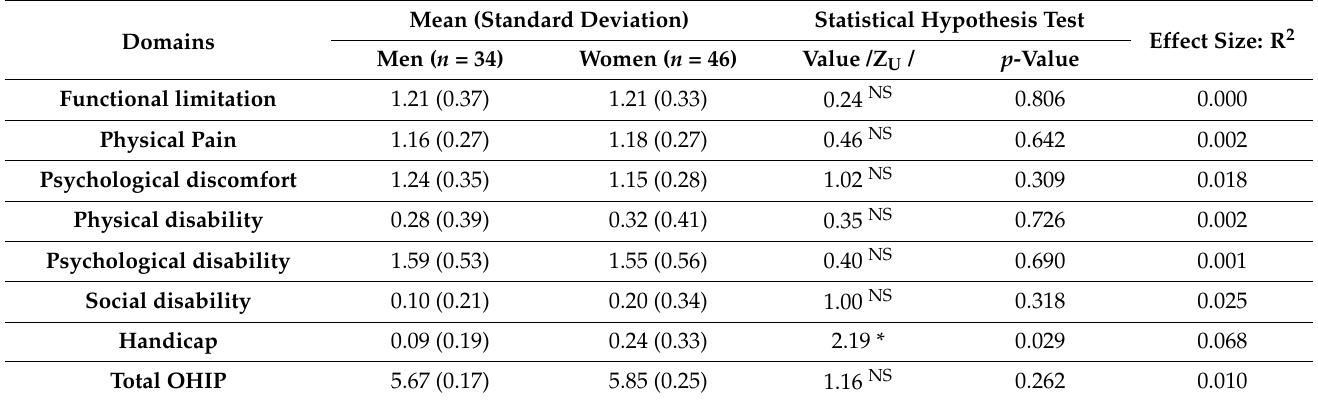
Table 3. Differences in the domains of the OHIP-14 questionnaire by gender ( n = 80).